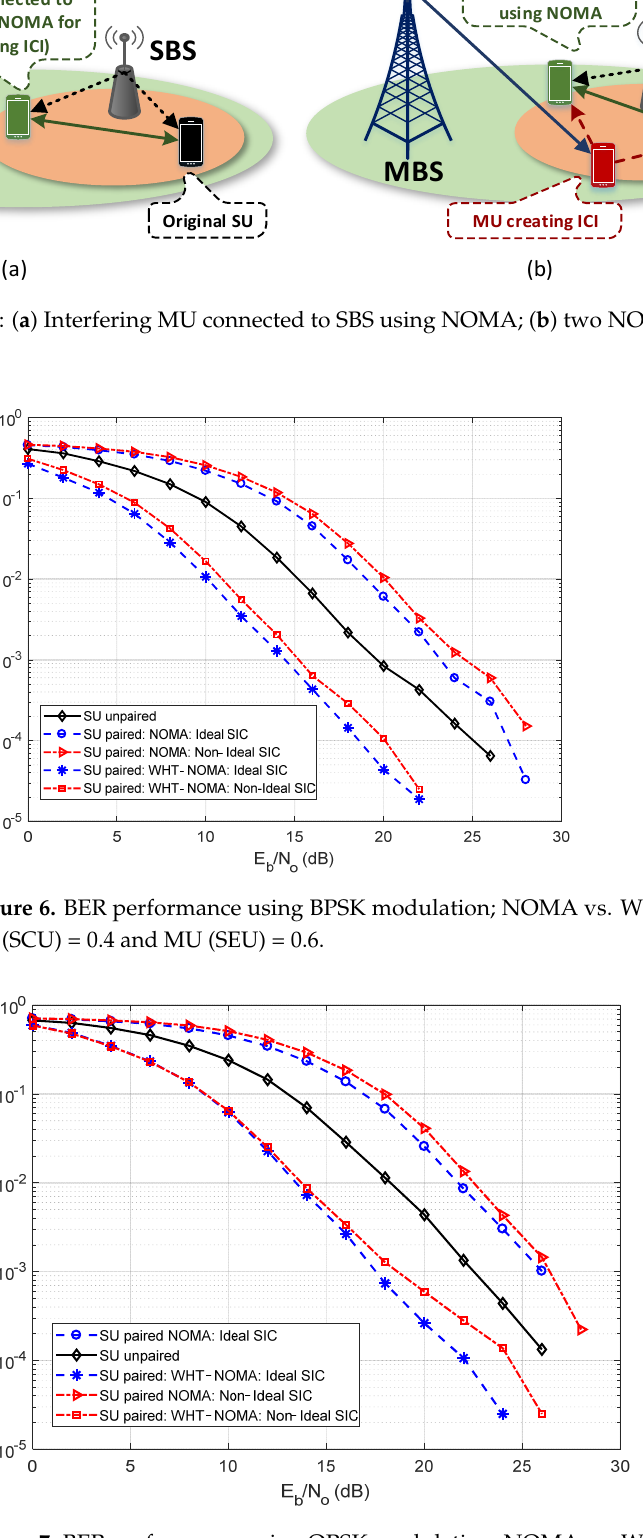
Figure 8. BER performance using QAM modulation; NOMA vs. WHT–NOMA, power allocation: SU (SCU) = 0.4 and MU (SEU) = 0.6.